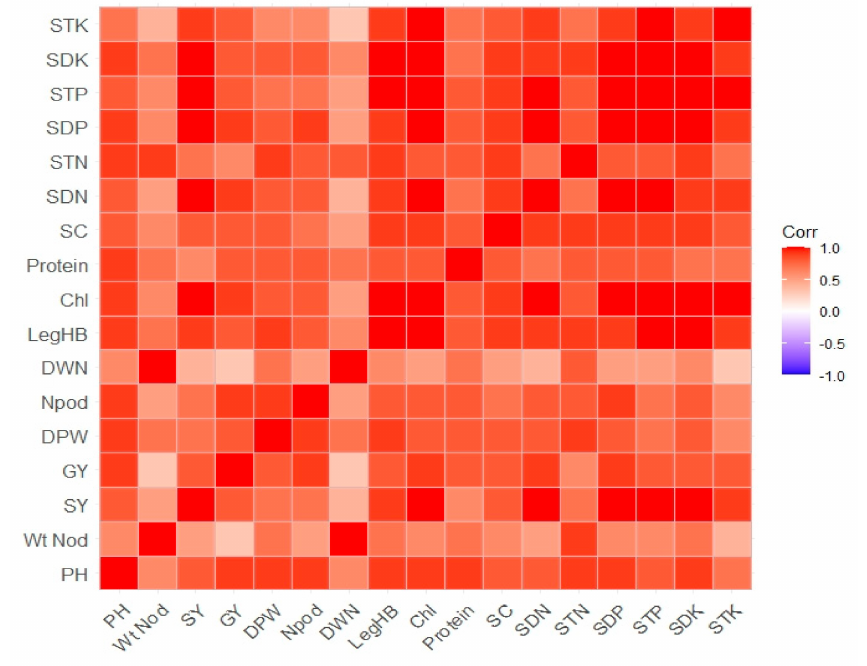
Figure 4. Represents correlation among measured parameters, where abbreviations of correlation matrix are as Grain Yield (GY), Stover Yield (SY), Chlorophyll contents (Chl), Number of pods (N pod), Seed carbohydrate contents (SC), Plant height (PH), Leghaemoglobin contents (Leg HB), Dry pod Weight (DPW), Protein contents (Protein), Weight of nodules (Wt Nod), dry weight of nodules (DWN), Stover K (STK), Seed N (SDN), Stover P (STP), Seed P (SDP), Stover N (STN), and Seed K (SDK). Dark red = highly positive, Light red = less